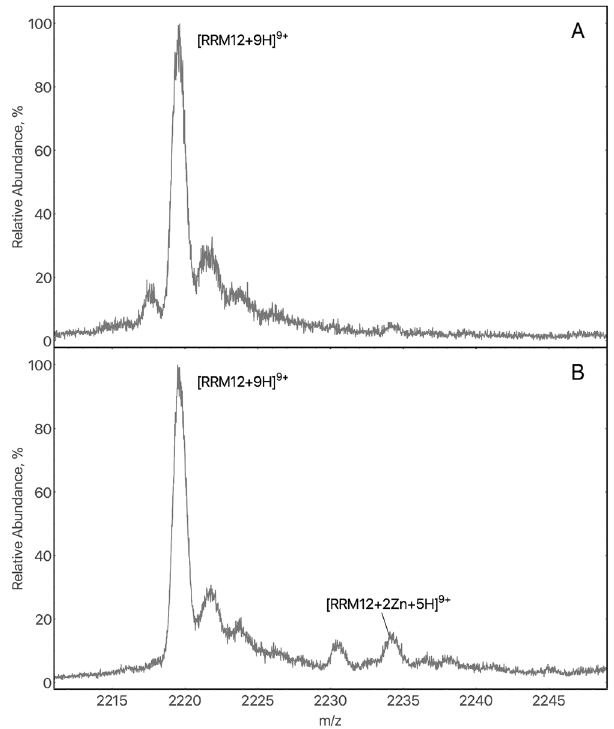
Figure 2. ( A ) Mass Spectrum of 25 µ M RRM12 in the absence of zinc ions. Zoom on the 9 + charge state ion (2219.7 m/z) from a six-charge state envelope. Calculated average mass for the major peak is 19967.7 ± 1 Da (the theoretical mass of RRM12 is 19967.5 Da). ( B ) Mass Spectrum of 25 µ M RRM12 in the presence of two-fold excess of zinc ions. A new peak at 2234.1 m/z, calculated average mass 20098 ± 1.4 Da, correspond to the species